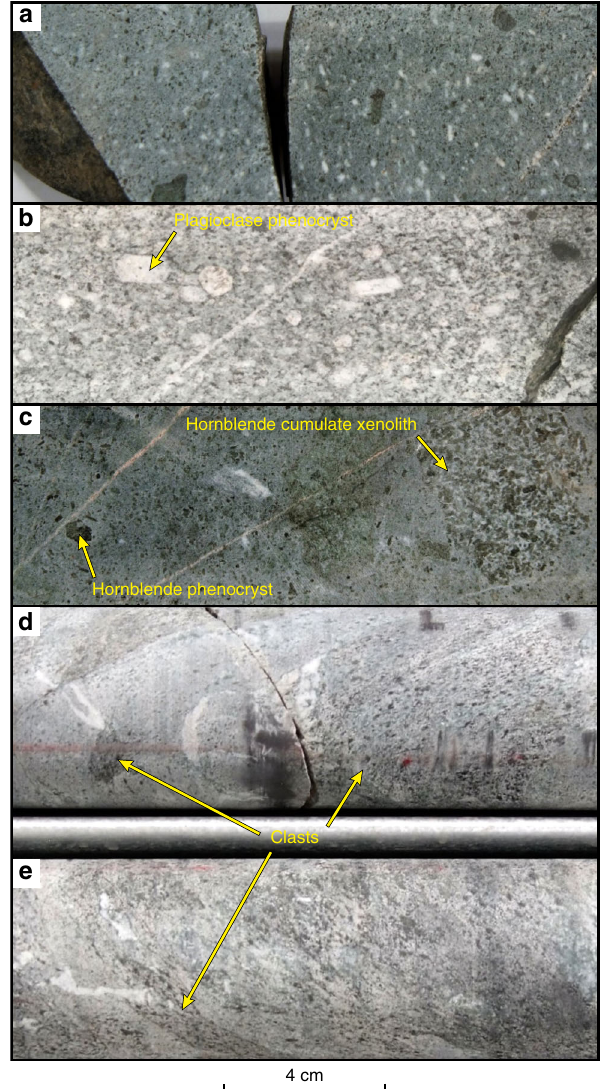
Fig. 3 Photographs of sanukitoid in drill core from the Kalgoorlie to Kambalda region. a A fi ne-grained and relatively primitive volcaniclastic rock from the Black Flag Group (BFG); b an evolved and strongly porphyritic subvolcanic sanukitoid intrusion; c a primitive subvolcanic sanukitoid intrusion containing hornblende phenocrysts and hornblende cumulate xenoliths; d, e volcaniclastic breccia comprising clasts or fragments on fi ne- to medium-grained hornblende-porphyritic BFG in a matrix of fi ne- grained